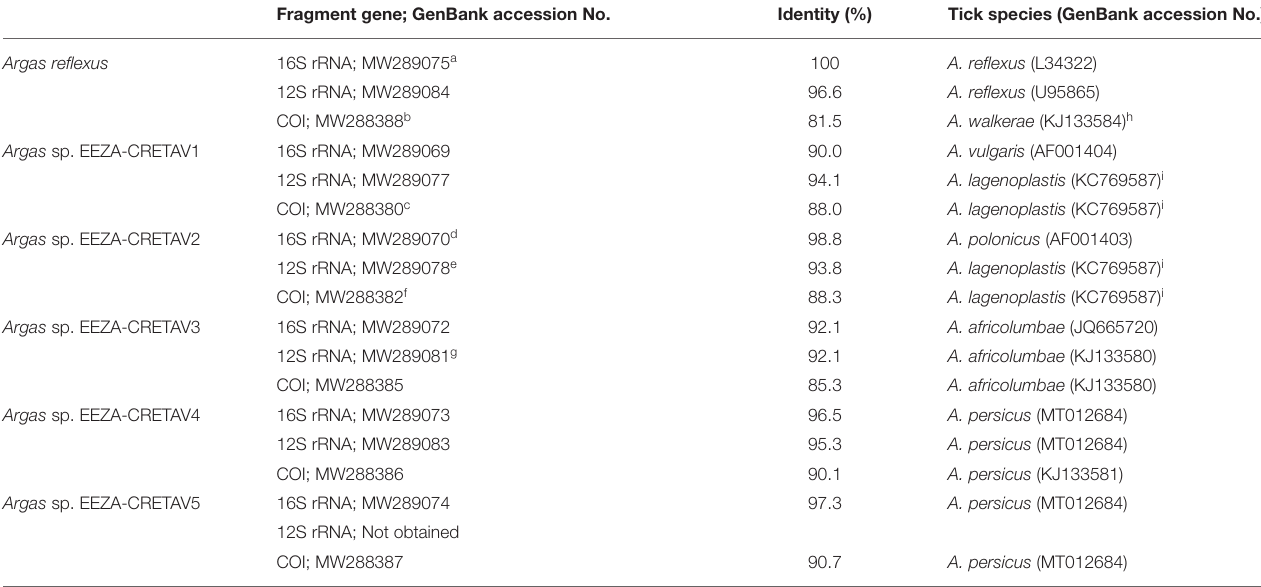
TABLE 2 | Highest similarities of the Argas genotypes detected in this study reached with public sequences from GenBank. Fragment gene; GenBank accession No. Identity (%) Tick species (GenBank accession